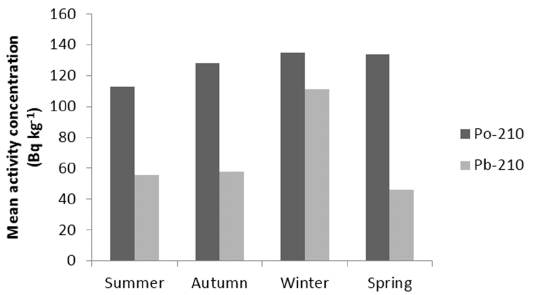
Figure 3. The seasonally mean value of 210 Po and 210 Pb in surface sediment.